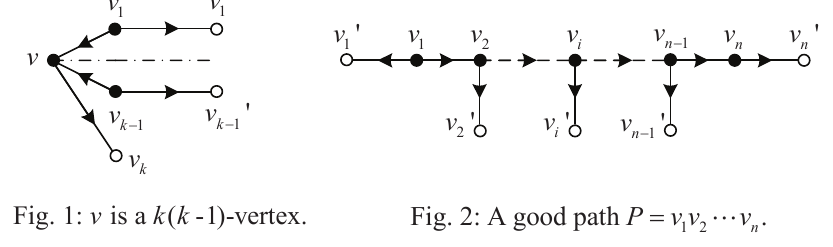
Fig. 2: A good path .